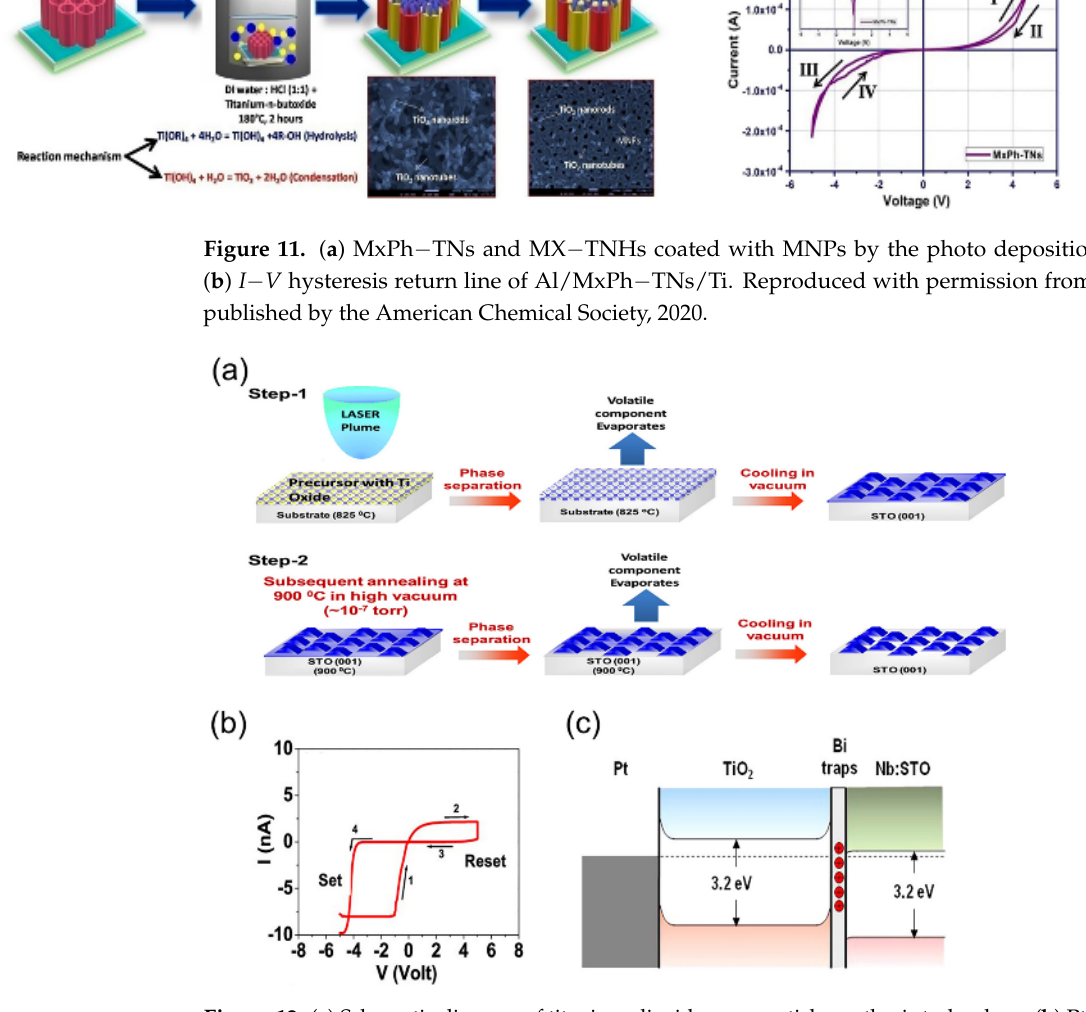
Figure 12. ( a ) Schematic diagram of titanium dioxide nanoparticle synthesis technology. ( b ) Pt/TiO 2 /Nb volt ampere characteristics of SrTiO 3 (STO) devices. ( c ) The energy band diagram of a Pt/TiO 2 /Nb:STO device during thermal equilibrium. Reproduced with permission from Ref. [79]; published by the American Chemical Society,